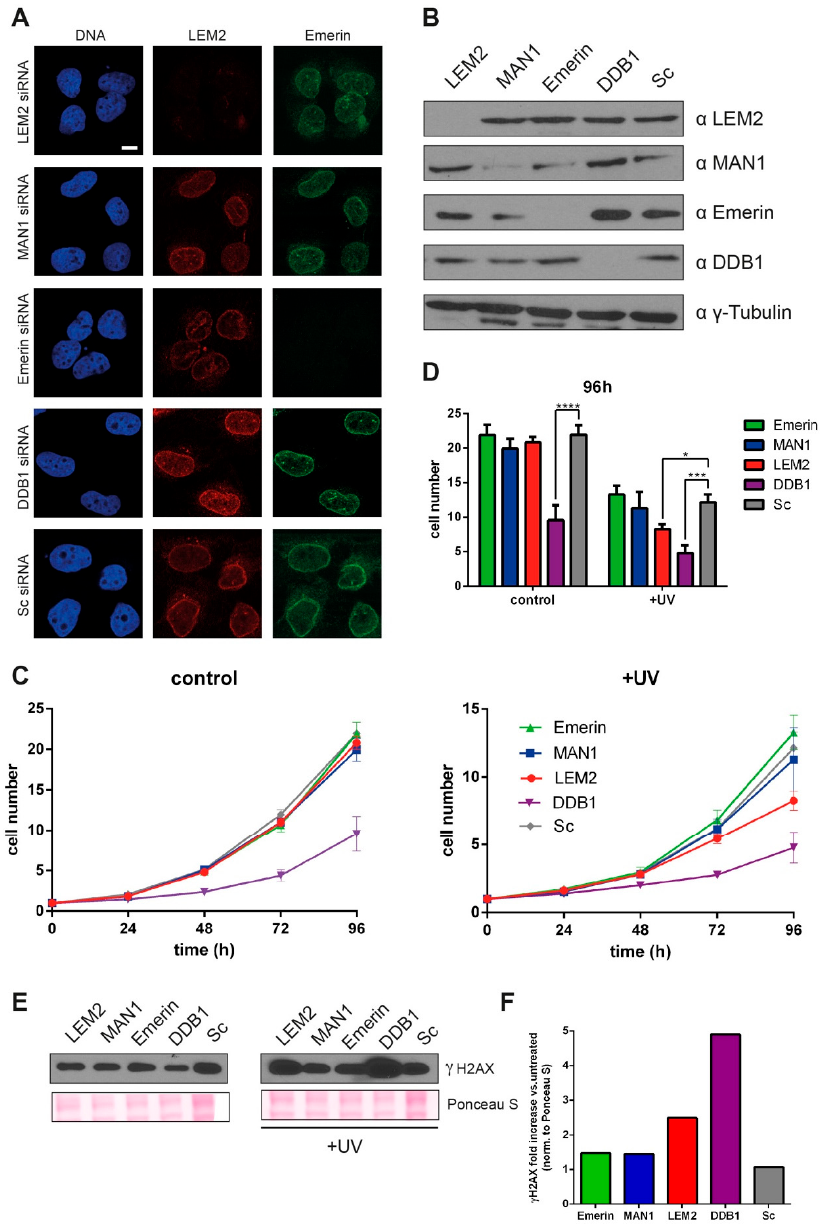
Figure 4. LEM2 knockdown impairs DNA damage response after UV-C irradiation. U2OS cell viability was accessed following knockdown of emerin, MAN1, LEM2 or DDB1 by RNA interference. Scrambled RNA (Sc) was used as negative control. ( A ) Immunofluorescence analyses of U2OS cells 48 h after transfection with indicated siRNAs stained for DNA (blue), LEM2 (red) and emerin (green). Bar, 10 µ m. ( B ) Immunoblot analysis of whole-cell lysates 48 hours after transfection with indicated siRNAs using antibodies as indicated on the top. γ -Tubulin served as loading control. ( C ) Emerin- MAN1-, LEM2- and DDB1-depleted cells or cells treated with scrambled RNA were left untreated (control) or irradiated with a sublethal dose of UV-C (5 J / m 2 ) ( + UV) and cell proliferation was analyzed for 96 h postirradiation. ( D ) Bar graph representing cell numbers at the 96 h time point. Statistical analysis was performed using two-way ANOVA and Tukey’s multiple comparison, n = 8, *, p -values: ‘*’ for p < 0.05; ‘**’ for p < 0.01; ‘***’ for p < 0.001; ‘****’ for p < 0.0001. Error bars represent standard error of the mean. ( E ) Whole cell lysates were analyzed by immunoblotting before and 48 h after UV treatment, using antibodies to phosphorylated H2AX ( γ H2AX). Ponceau S stain served as loading control. ( F ) Quantification of immunoblot. Graph represents fold increase of γ H2AX after UV treatment normalized to total